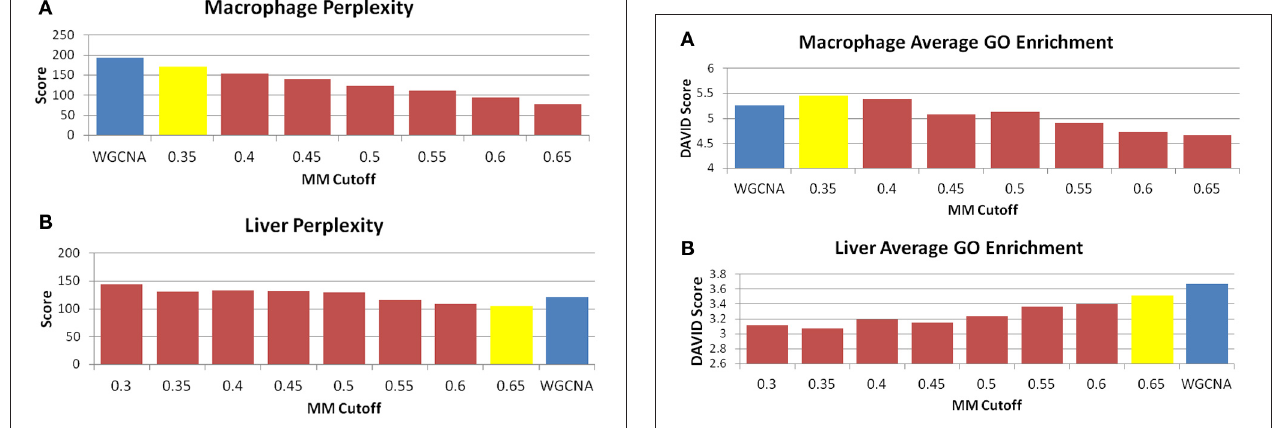
FIGURE 6 | MICA returns a small improvement in module entropy over WGCNA. Perplexity measures for (A) macrophage and (B) liver. The blue bar is the score received by WGCNA, while the yellow bar is the score returned for MICA at the optimal MM cutoff. As perplexity is a measure of entropy, a lower score is more desirable. In both cases, a small improvement in perplexity is observed in the optimal MICA modules vs. the WGCNA modules.